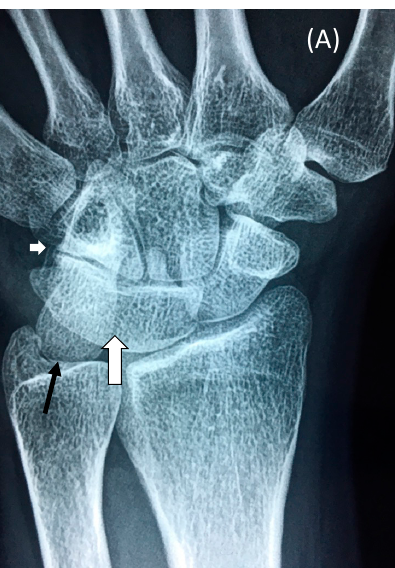
Figure 5. Wrist Radiographs. Radiographs of the wrist of an affected female member of the family (IV-12) displaying ( A ) Dorsal view of the wrist with fusion of the lunate and triquetrum (large white arrow), partial fusion of the hamate and pisiform (small white arrow) and extensive elongation of the pisiform into articulation with the radial surface of the styloid process of the ulnar (black arrow); ( B ) Side view of elongated pisiform (large white arrow) and partial fusion of hamate and pisiform (small white arrow) [13].